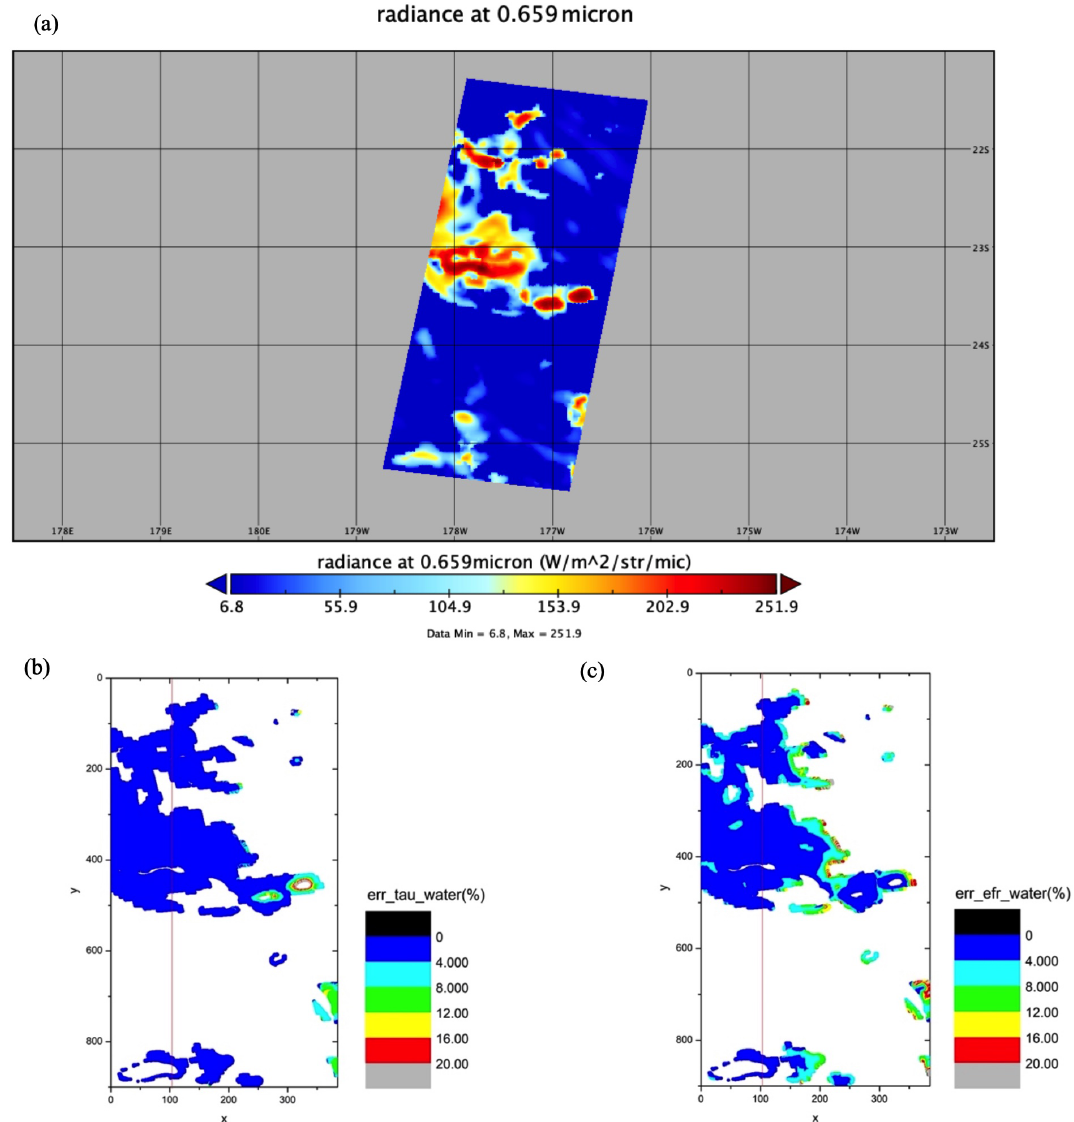
Figure 15. NICAM/Joint-Simulator data for shallow warm clouds. (a) Radiance at 0.659µm (band 1 of MSI), (b) error distribution of COT, and (c) error distribution of CDR. x and y in (b) and (c) show the pixel number in the swath or track direction. The red line in (b) and (c) stands for the location of the